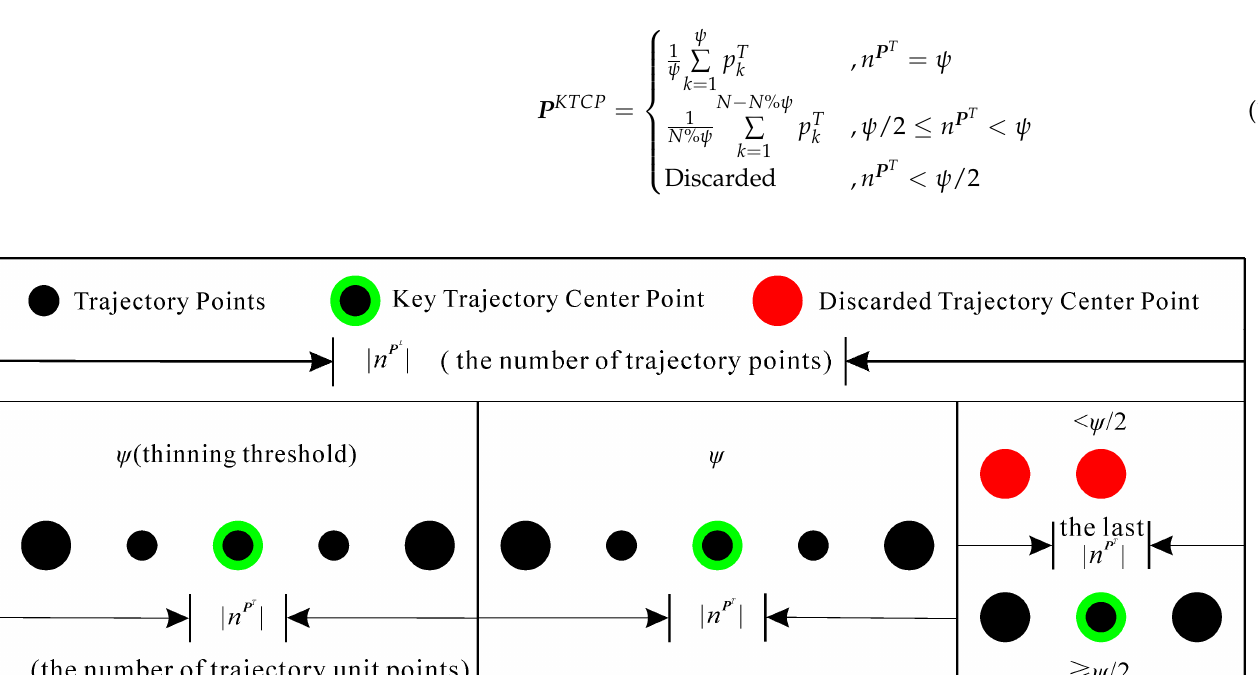
Figure 3. Schematic diagram of trajectory extraction.